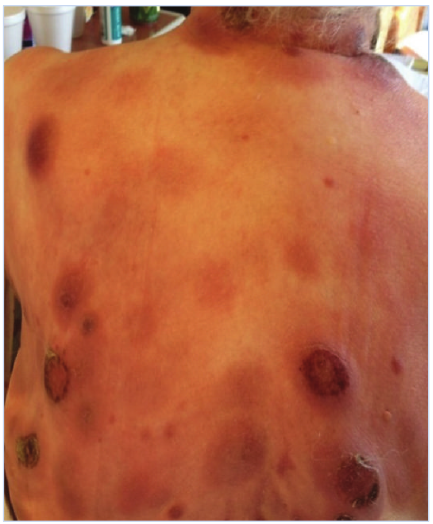
Figure2: Diffuse,multifocal red-violaceous nodules onthepatient’s back and neck. Several nodules are ulcerated and crusted and are exudative.